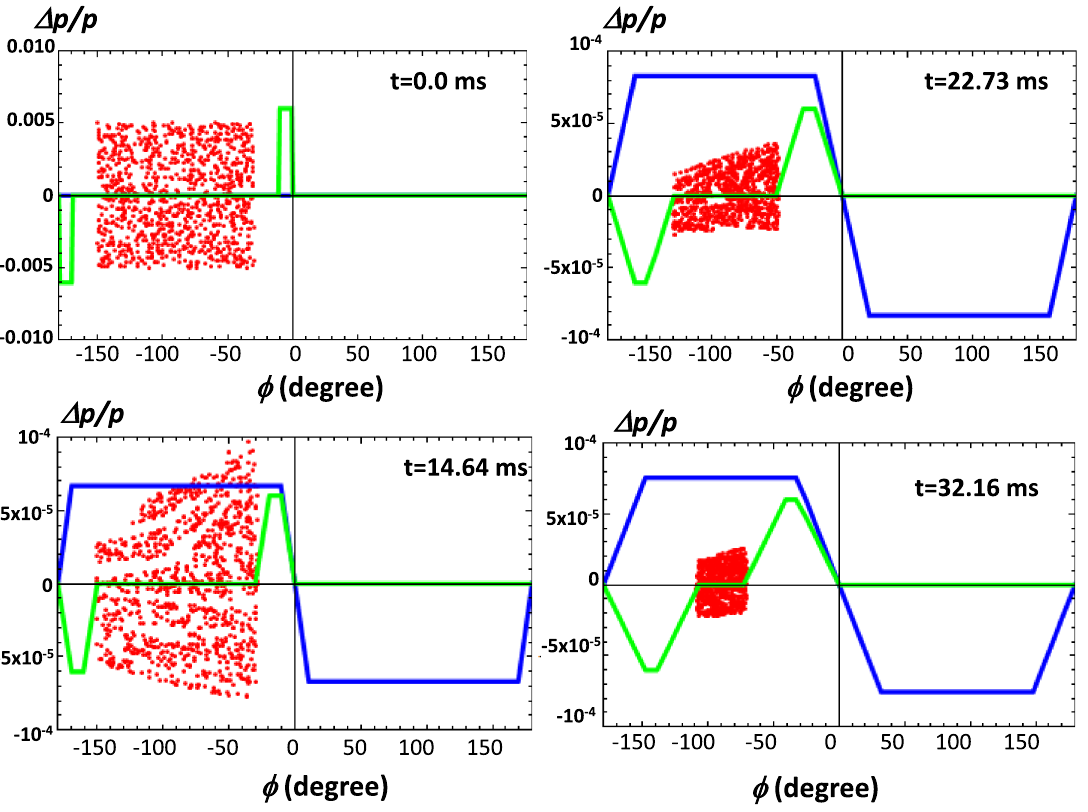
FIG. 10. Phase plots of tracked macroparticles in phase space with V ac and V bb ; voltage heights are shown in relative units. The asymmetric bunch profile seen in the early time period of acceleration is generated by a combination of the reflection due to the right hand barrier voltage pulse with a relatively steep voltage rising profile and dependence of the phase velocity on Δ p=p